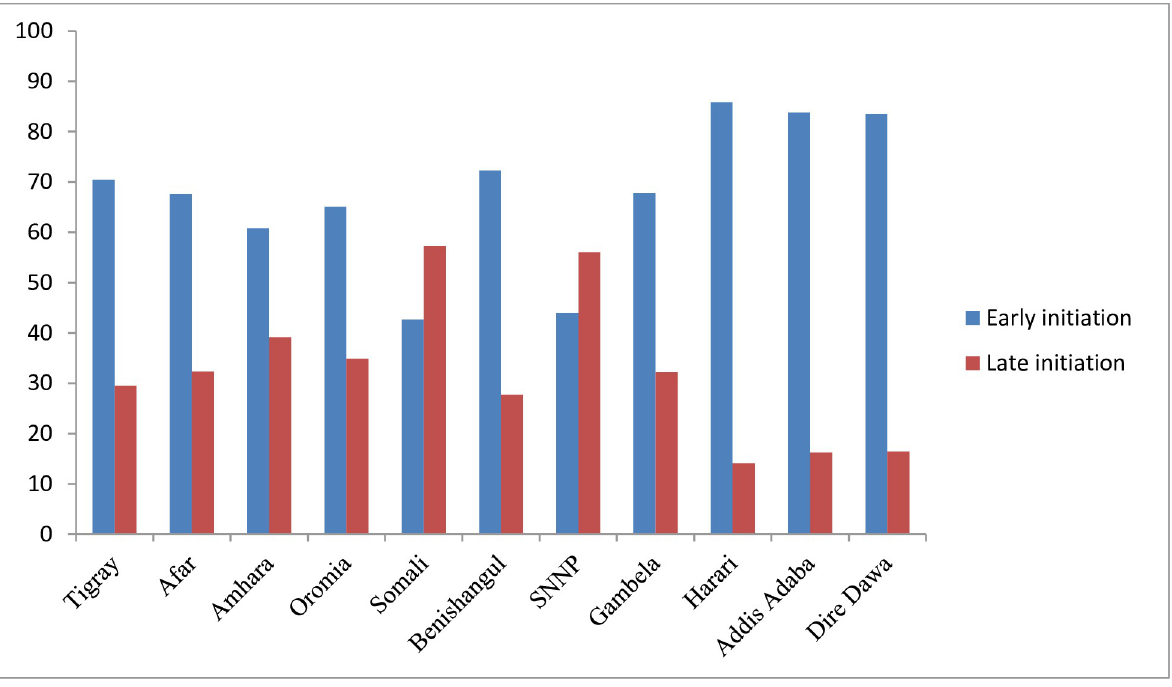
Fig 2. Time of ANC booking among women by regions in Ethiopia,